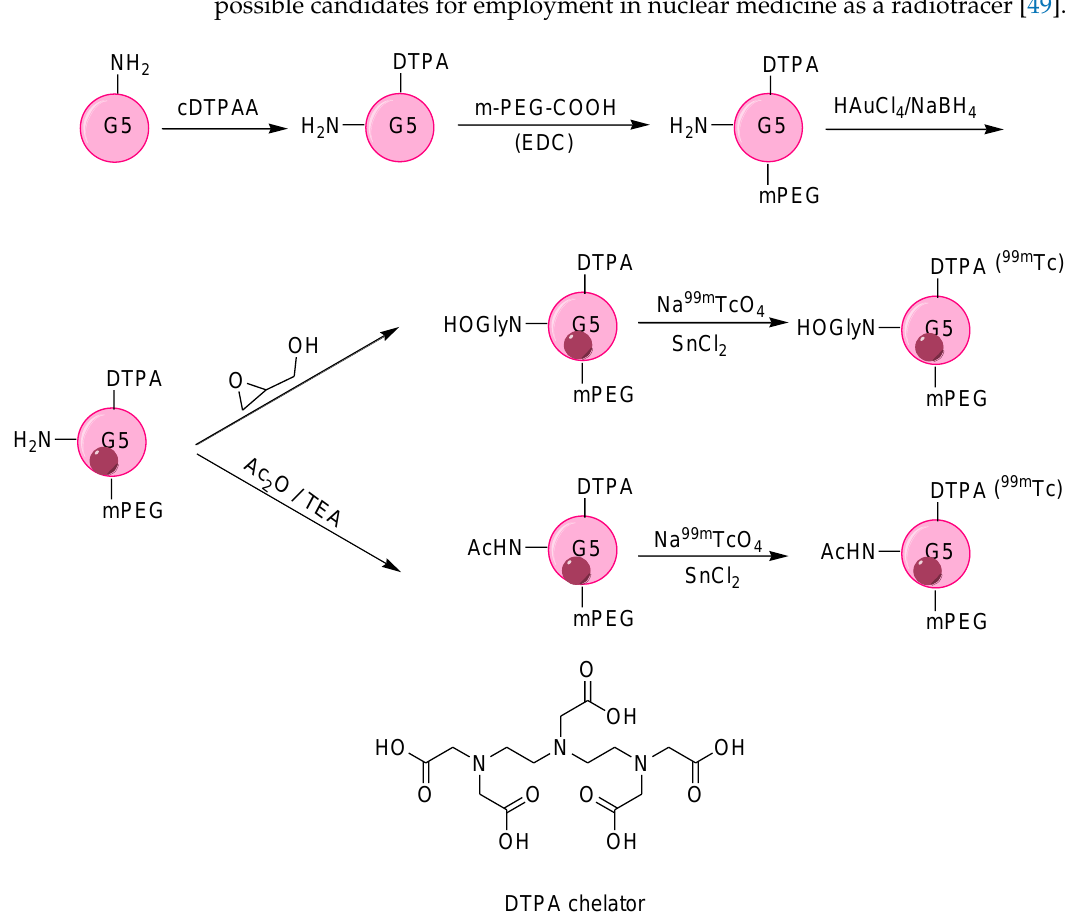
Figure 7. Schematic representation of the synthesis of 99m Tc-Au–Gly DENPs and 99m Tc-Au–Ac DENPs [46]. The direct radiolabeling of silica NPs provided satisfactory results regarding in vitro and in vivo stability. However, chelator-based radiolabeling techniques still provide superior results. After synthesis, radiolabeled mesoporous silica NPs (MSNs) were allowed to functionalize with APTES, followed by anchoring through DTPA as a 99m Tc chelator. The product was purified by ultracentrifugation to obtain high radiochemical yields (over 95%) and enhanced stability [50]. For 99m Tc-DTPA-MSN, high uptake in the liver was observed, with fast clearance from the blood, followed by a maximum accumulation of tracer in the lungs, thus making these structures a potential candidate for theranostic purposes. The radiolabeling and biodistribution studies using the silica NP platform demonstrated promising results, and stimulated further development. HER2 is